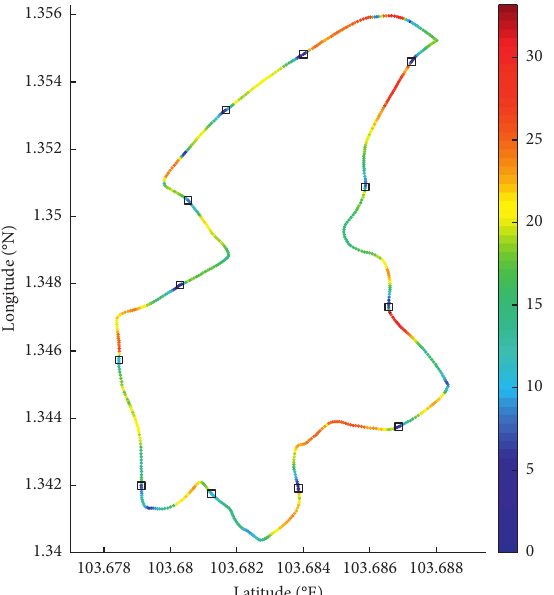
Figure 1: Average velocity of the buses at different positions of the route. The path represents the 688 discretized positions of the route taken by NTU-SBS. The X and Y values represent actual GPS coordinates of the bus route. The color describes the average velocity in units of km/h. Buses move clockwise around the loop.